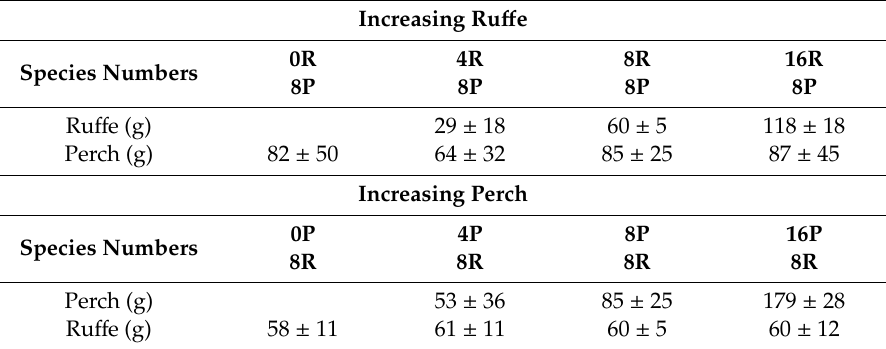
Table 4. Mean total biomass ± 95% C.I. of ru ff e (R) and yellow perch (P) in treatments of the 1997 fish density gradient experiment. There were four replicates of each treatment except for the 0R + 8P and 4R + 8P treatments for which there were three replicates and 8R + 8P (6 replicates). Increasing Ru ff